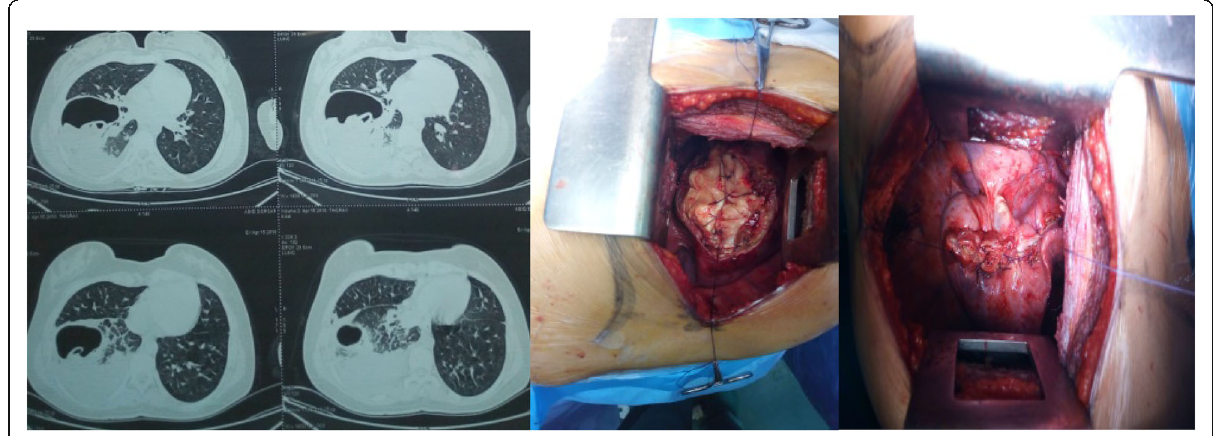
Fig. 2 a CT appearance of a complicated giant hydatid cyst (air-fluid level) of the right lower lung lobe. b Per-operative photo showing the